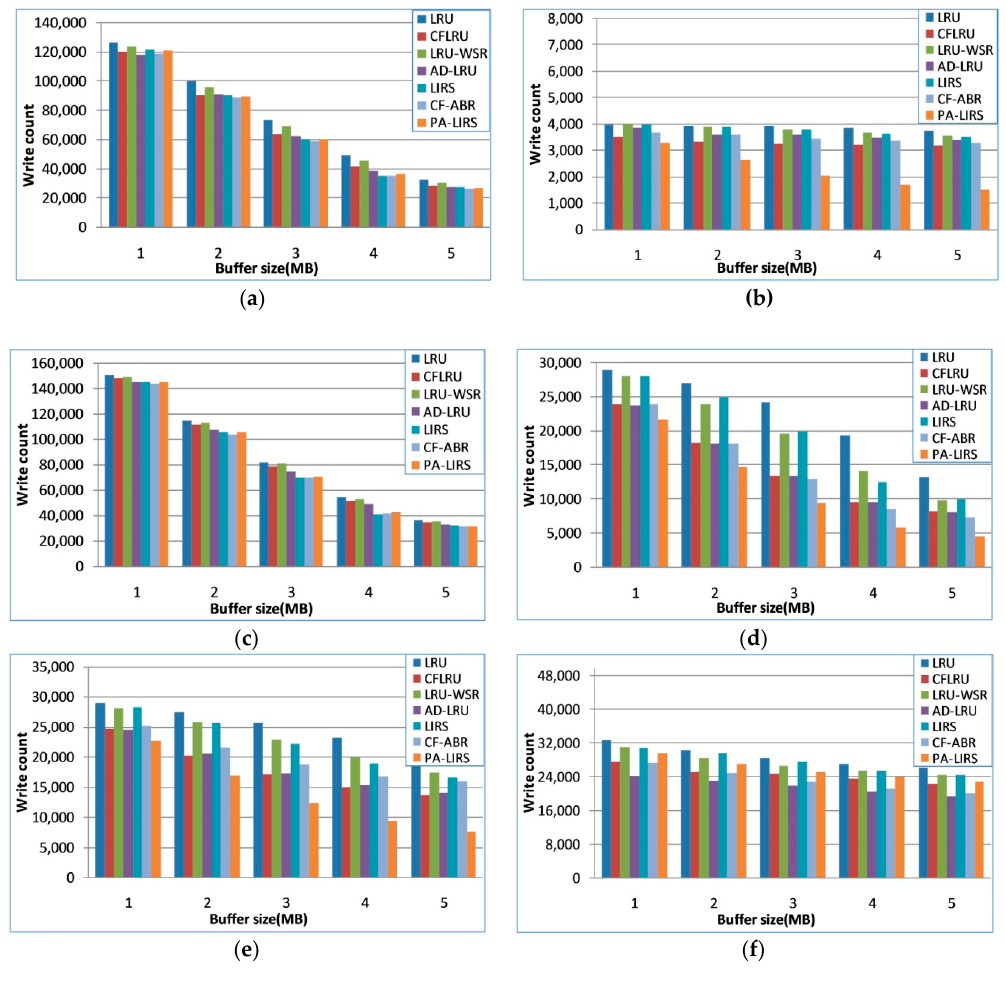
Figure 8. The flash write counts of different algorithms under 6traces. ( a ) T1 trace, ( b ) T2 trace, ( c ) T3 trace, ( d ) T4 trace, ( e ) T5 trace and ( f ) OLTP trace.